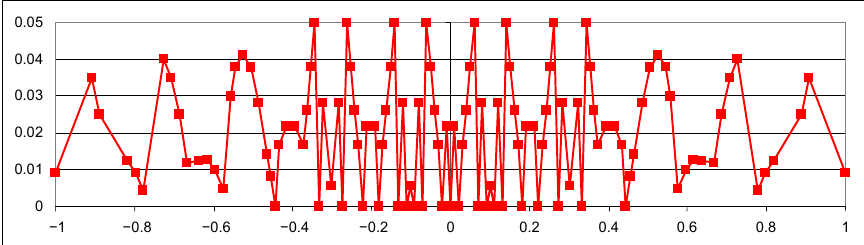
Figure 16. CI ER,5% (0..9, 0..11, 9, 11) non-CP for sampling without